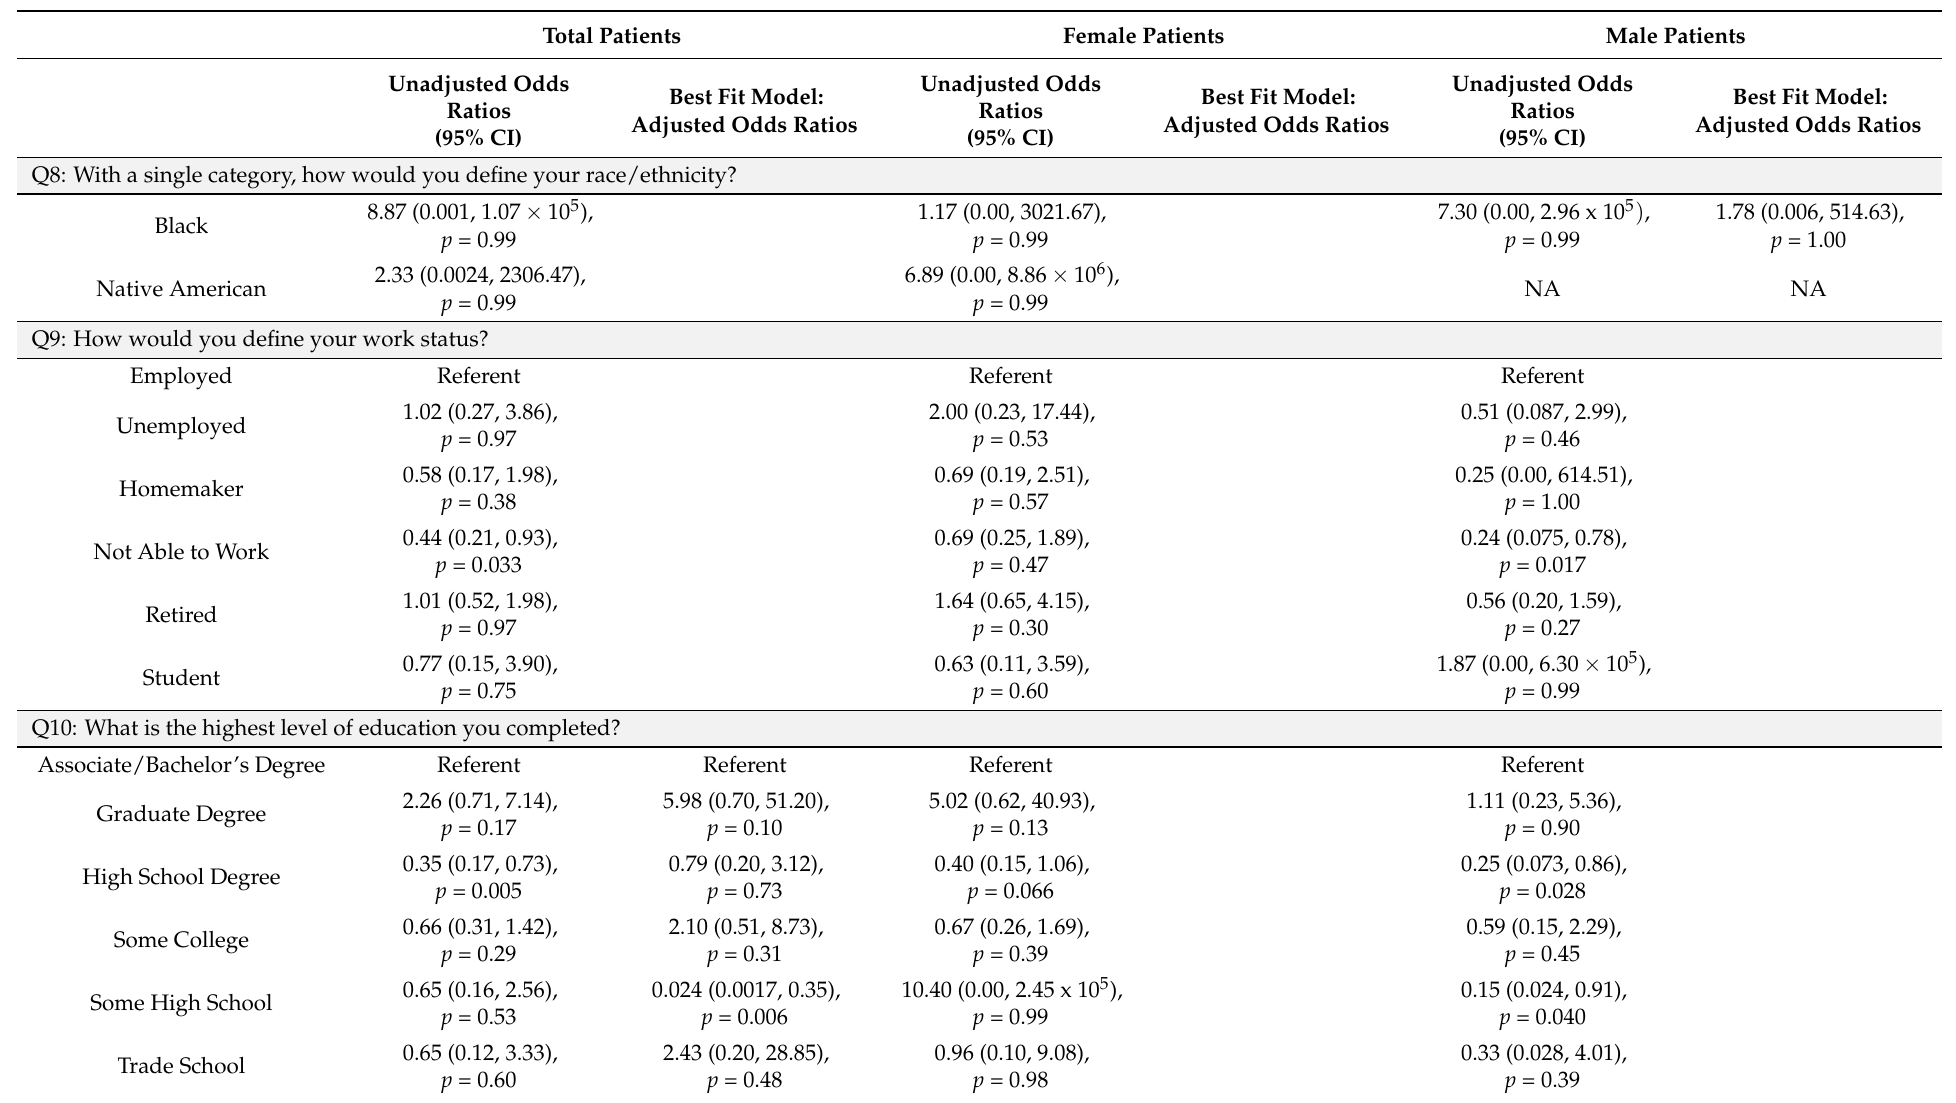
Total Patients Female Patients Male